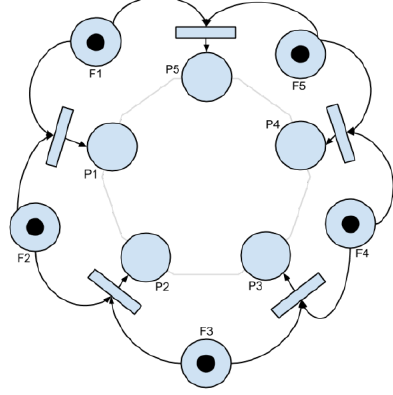
Fig. 8. Dining Philosopher modeled using Petri Net modeling notation